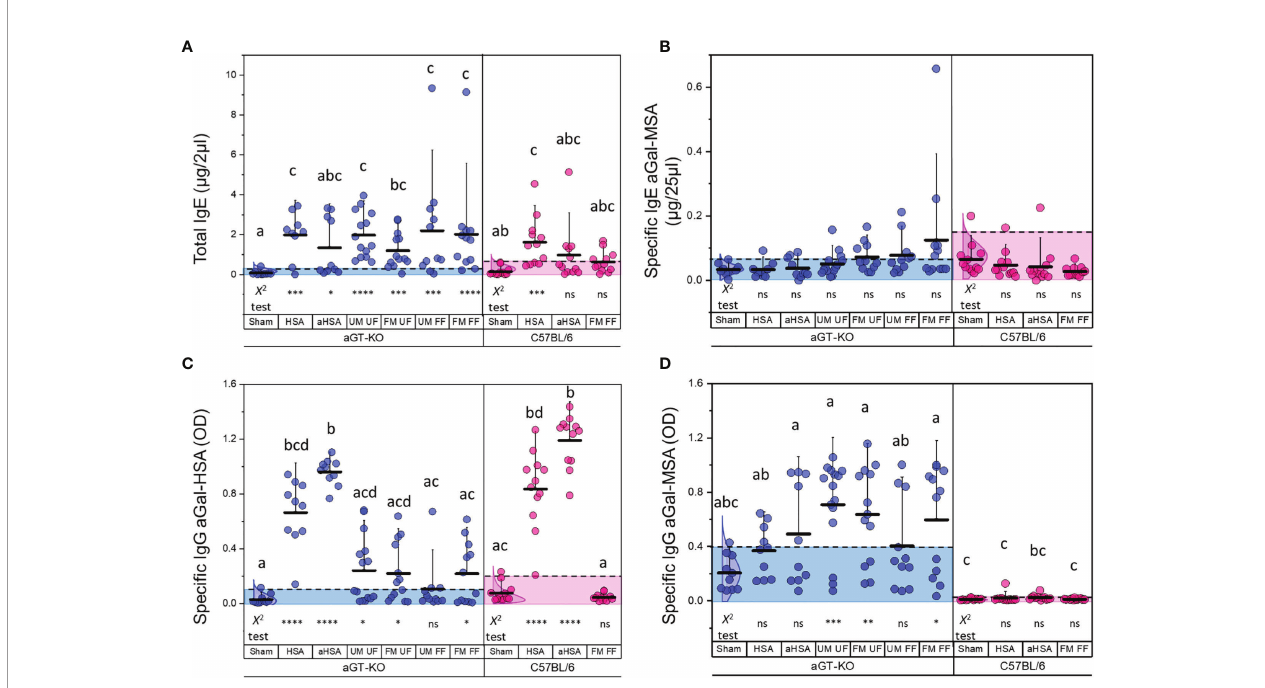
FIGURE 3 | Total and speci fi c IgE to aGal and speci fi c IgG levels to aGal-HSA and aGal-MSA. (A) Total IgE levels of different treatment groups (in µg/2 µl of serum) in aGT-KO mice (blue) and C57BL/6 mice (magenta). (B) Speci fi c IgE to aGal-MSA (in µg/25 µl of serum). (C) Speci fi c IgG to aGal-HSA (OD value) and (D) Speci fi c IgG to aGal-MSA (OD value). Note that the positive control for aGal is the immunization by aHSA when speci fi c immunoglobulins against aGal-MSA were measured. Axis labels; HSA, human serum albumin; aHSA, aGal conjugated to HSA; UM, unfed male tick; UF, unfed female tick; FM, fed male tick; FF, fed female tick. The alphabets show the signi fi cant differences at p = 0.05 in Kruskal-Wallis ANOVA test. Lack of alphabets represents no statistical difference seen. Error bars represent the mean (lower horizontal bar) and standard deviation (upper vertical bars). Dotted lines and the shaded area show the cutoff for difference at 95% normal distribution of the control (sham control) for determining frequencies of differences, which was used for Chi-square test, and the statistics below the graph represent the Chi-square test results for signi fi cance indicated by *; *< 0.05, **< 0.01, ***< 0.001 and ns = not signi fi